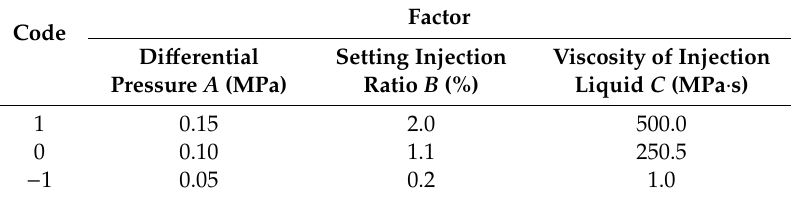
Table 2. Experimental factor and levels.